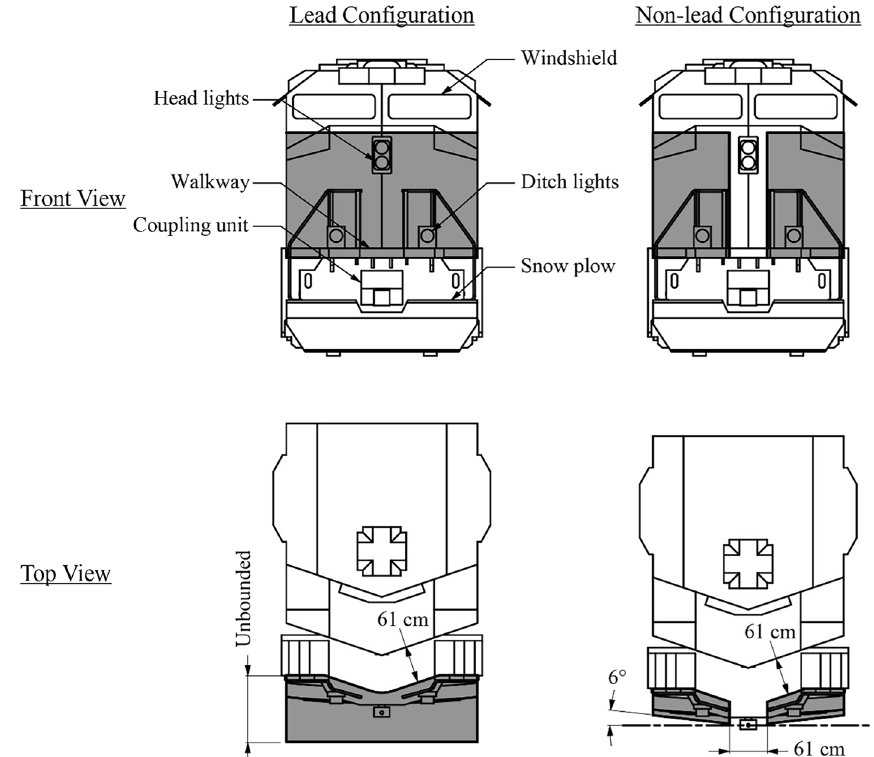
Fig. 1 Front and side views of a typical freight train locomotive. The gray regions in this figure highlight the space that is available for an add-on nose fairing. Due to the different spatial requirements for lead (left) and non-lead (right) locomotives, the available space is shown for both configurations. A top view and a front view are provided for each configuration. Devices on the locomotive that constrain the available space for the fairing are appropriately